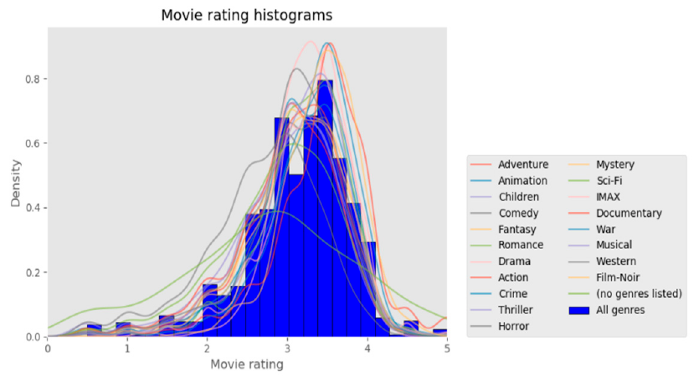
Figure 11. Ratings distribution in MovieLens 20M.